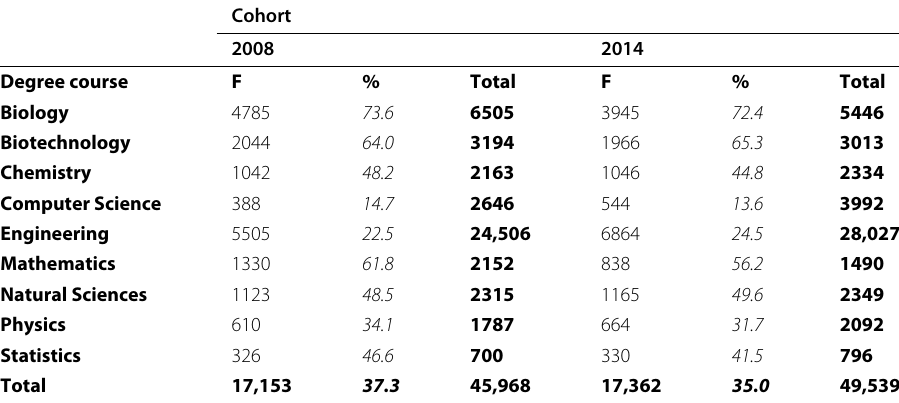
Table 1 Female students enrolled for the first time in STEM courses, and female enrolment rate of the 2008 and 2014